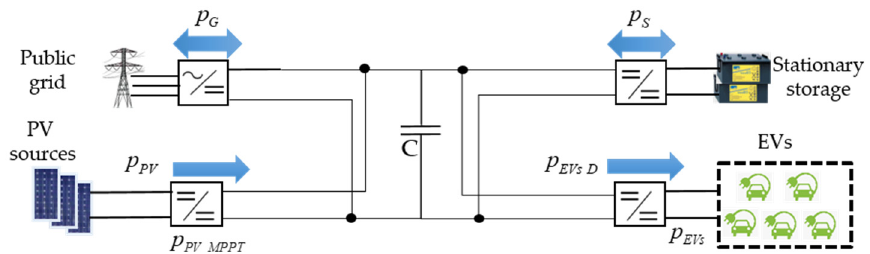
Figure 3. Photovoltaic (PV)-powered EV charging station scheme. p is the PV power in maximum power point tracking (MPPT) mode, Where PV MPPT p is the PV power, p is the public grid power, p is the stationary storage power, PV G S p p EVs D EVs